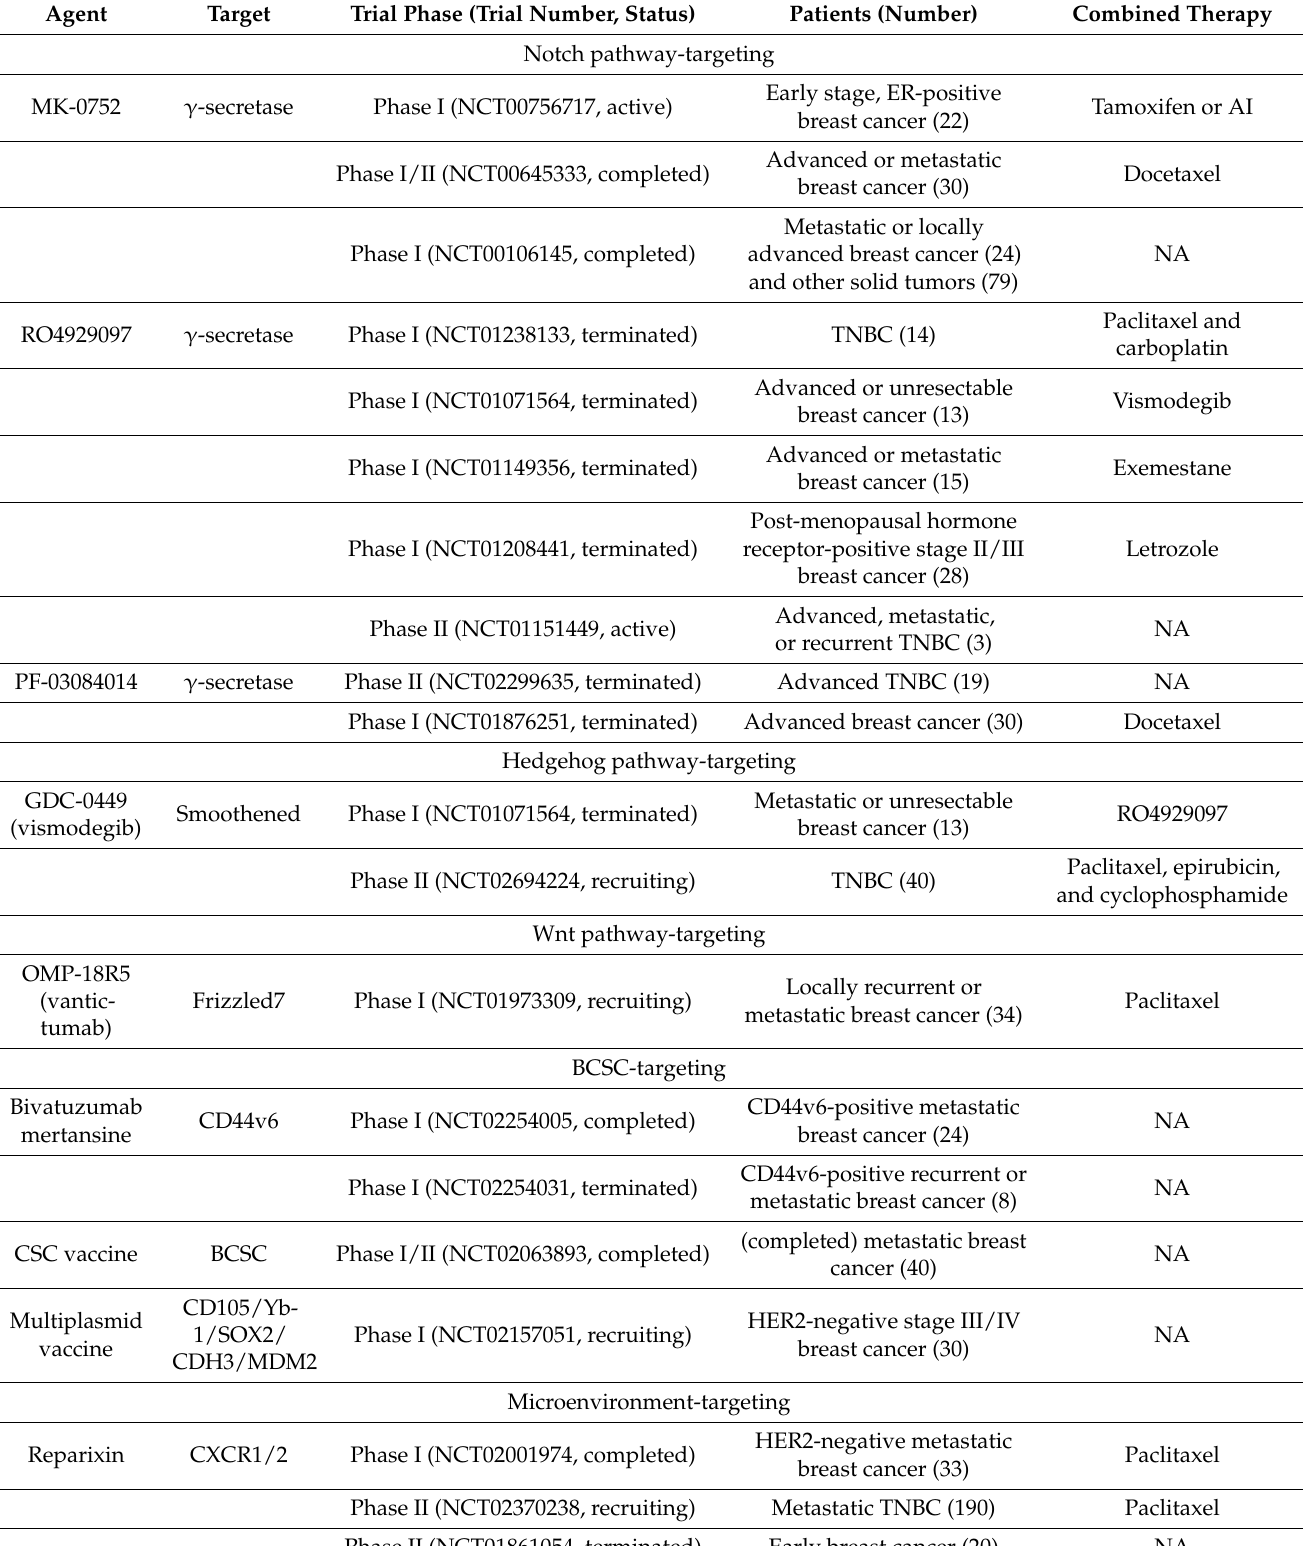
Table 3. Breast Cancer Stem Cells (BCSCs) targeting therapies in the clinical trials